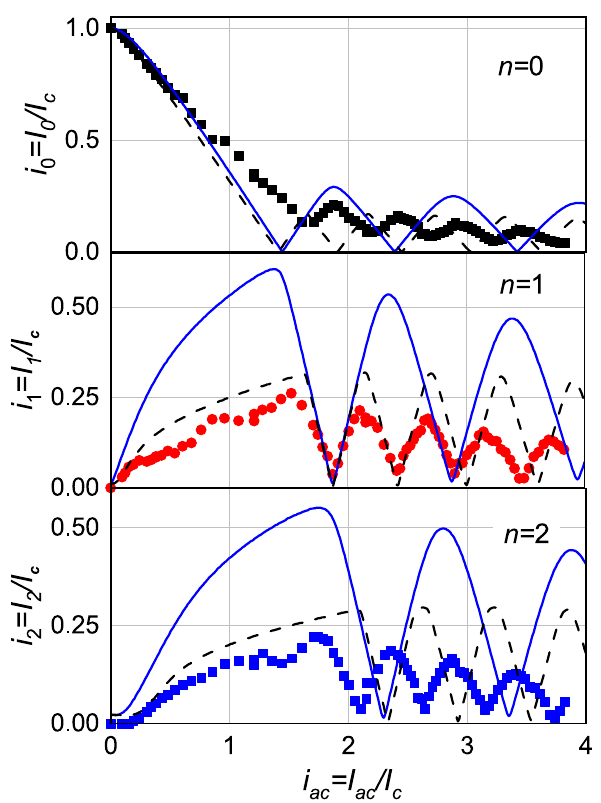
Figure 5. Symbols: experimental dependencies of the normalized critical current and amplitudes of the first √ √ exp P ) = I n ( k P )/ I c ( P = 0 ) ( n = 0, 1, 2 ) . Lines: approximation current steps for PC No. 1, plotted as i n ( k of experimental dependencies obtained from the RSJ Eq. (1) with (cid:31) VAC = 0.35 . The solid blue one has been obtained for the current-phase relationship I s = I c sin (ϕ) , the dashed black one for I s = I c sin ( 2 ϕ) . The x -axis √ calc − 2 ϕ exp P ) and i for the dependencies i n ( hi ac ) was rescaled so that the first minima of i n ( k i calc − 2 ϕ 1 ( hi ac ) coincide with the first minimum of i calc − ϕ 1 ( i ac ) . The coefficients k = 3.83 and h = 1.18 were